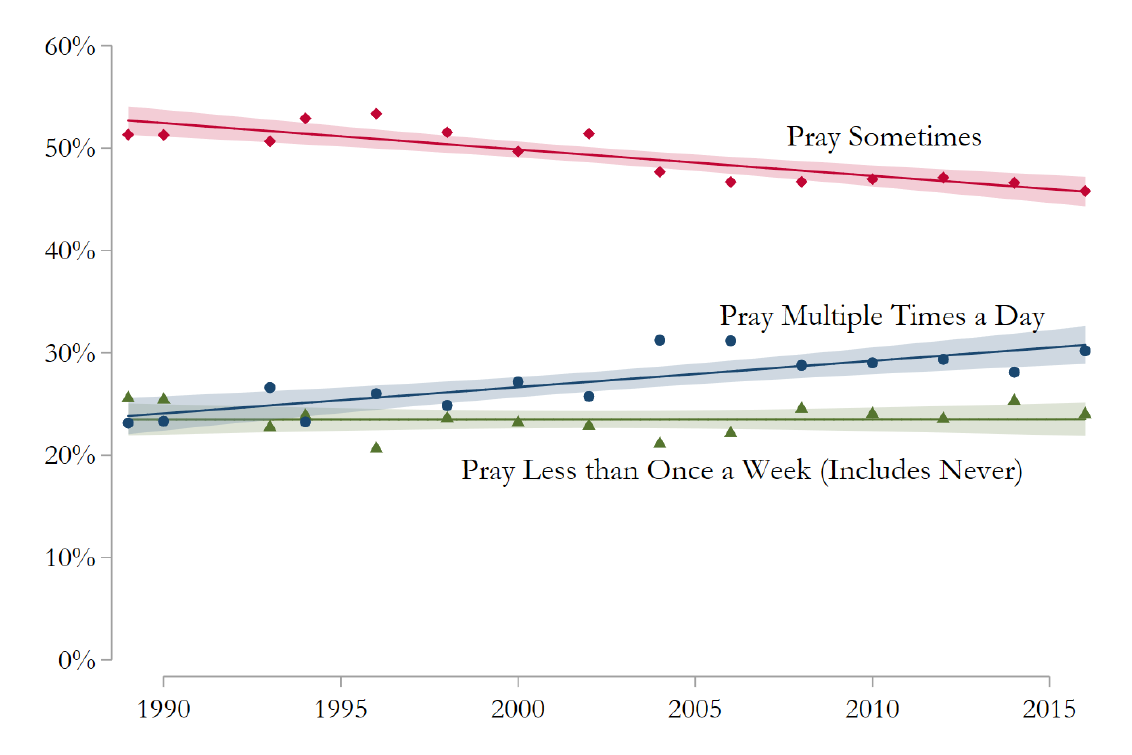
Figure 2: Prayer frequency over time, General Social Survey. Source: General Social Survey, 1989 to 2016. Note: The five consistent GSS prayer response options are less than once a week = 1, once a week = 2, several times a week = 3, once a day = 4, and several times a day = 5. Before 2004 the GSS question did not include a “never” option, though a few people did volunteer it, and praying less than once a week was the most infrequent response option stated in the survey. After 2004, the GSS included “never” as an option. We combine less than once a week and never to make the values comparable over time. “Pray sometimes” includes options 2 through